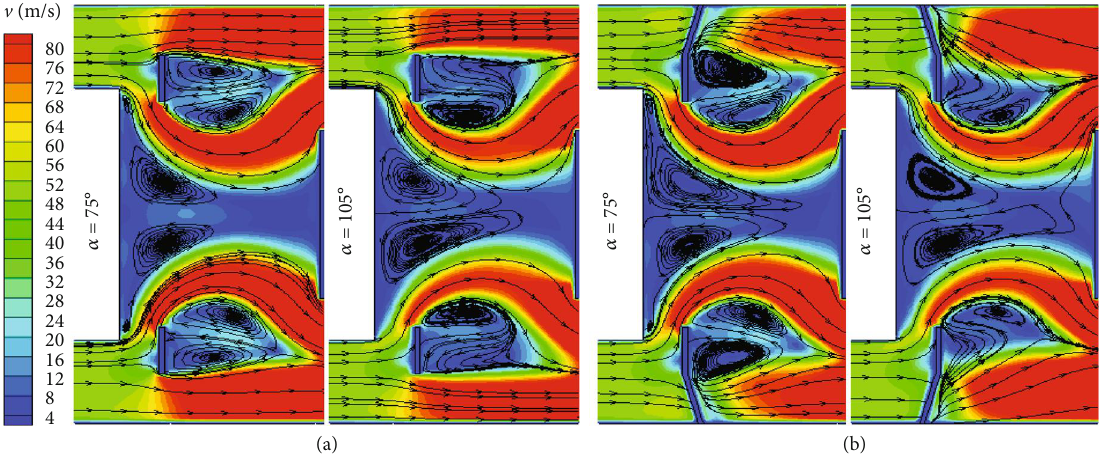
Figure 4: Velocity distribution under di ff erent struts inclining direction.